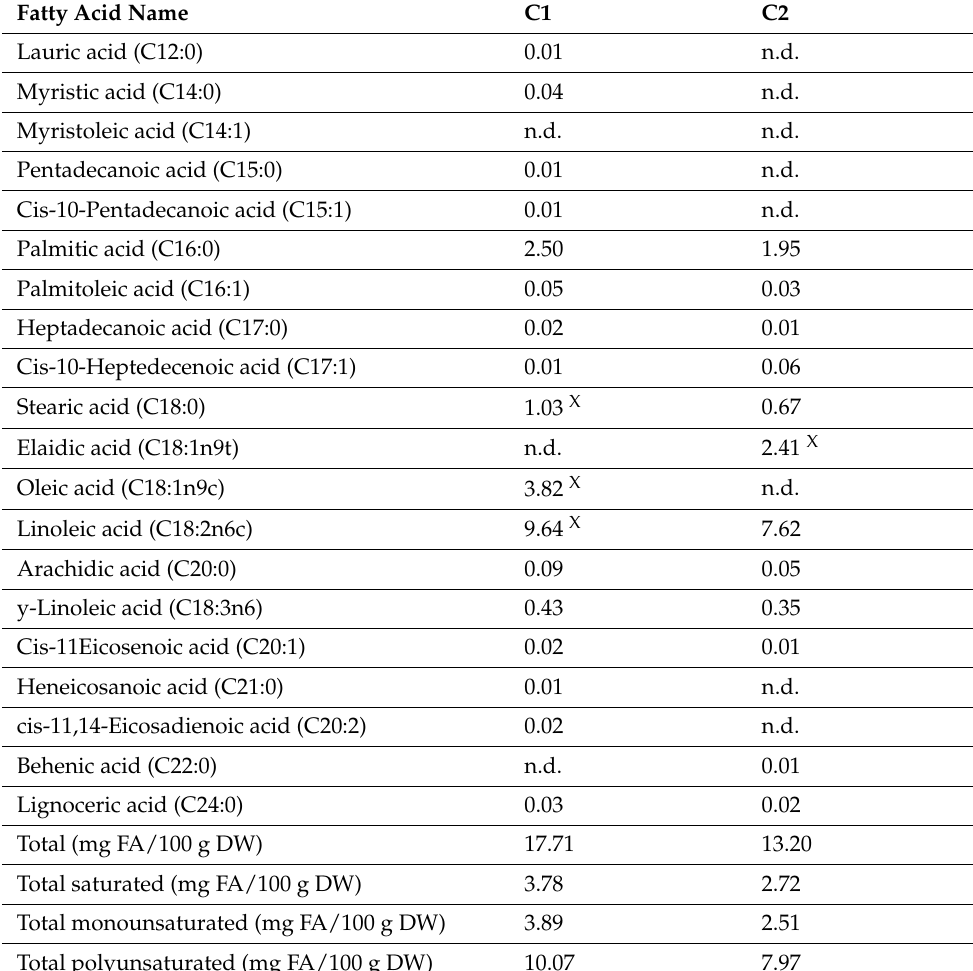
Table 2. Fatty acids profile (identification and quantification) of tomato by-products.